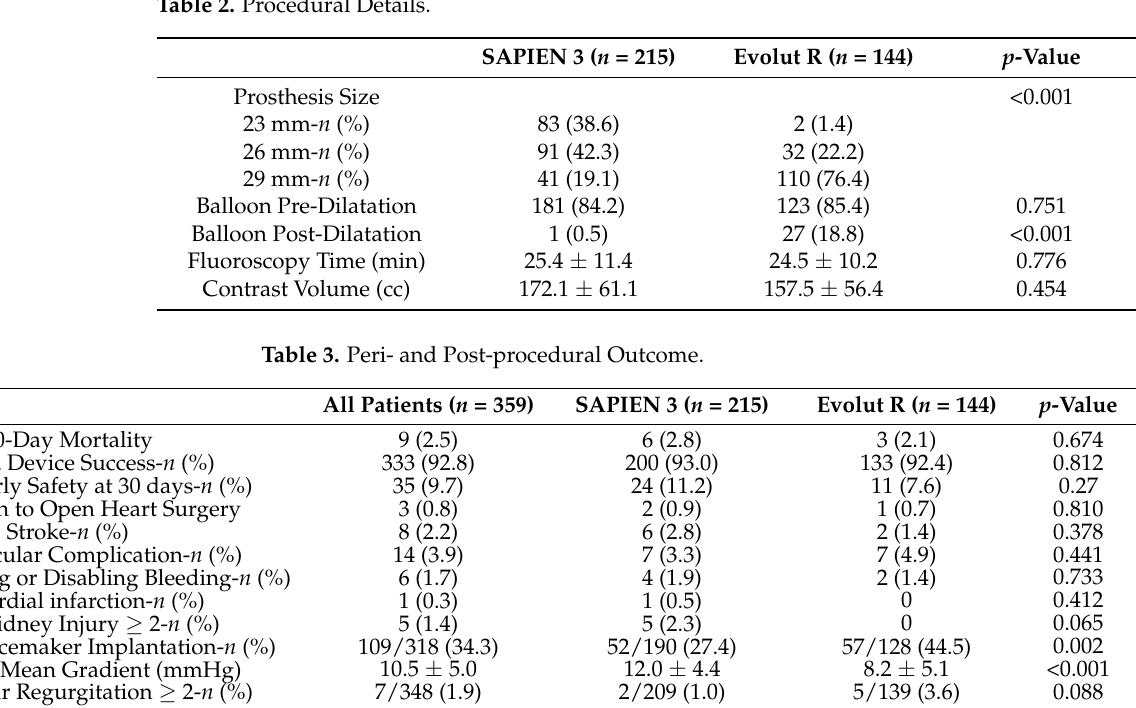
Table 2. Procedural Details.